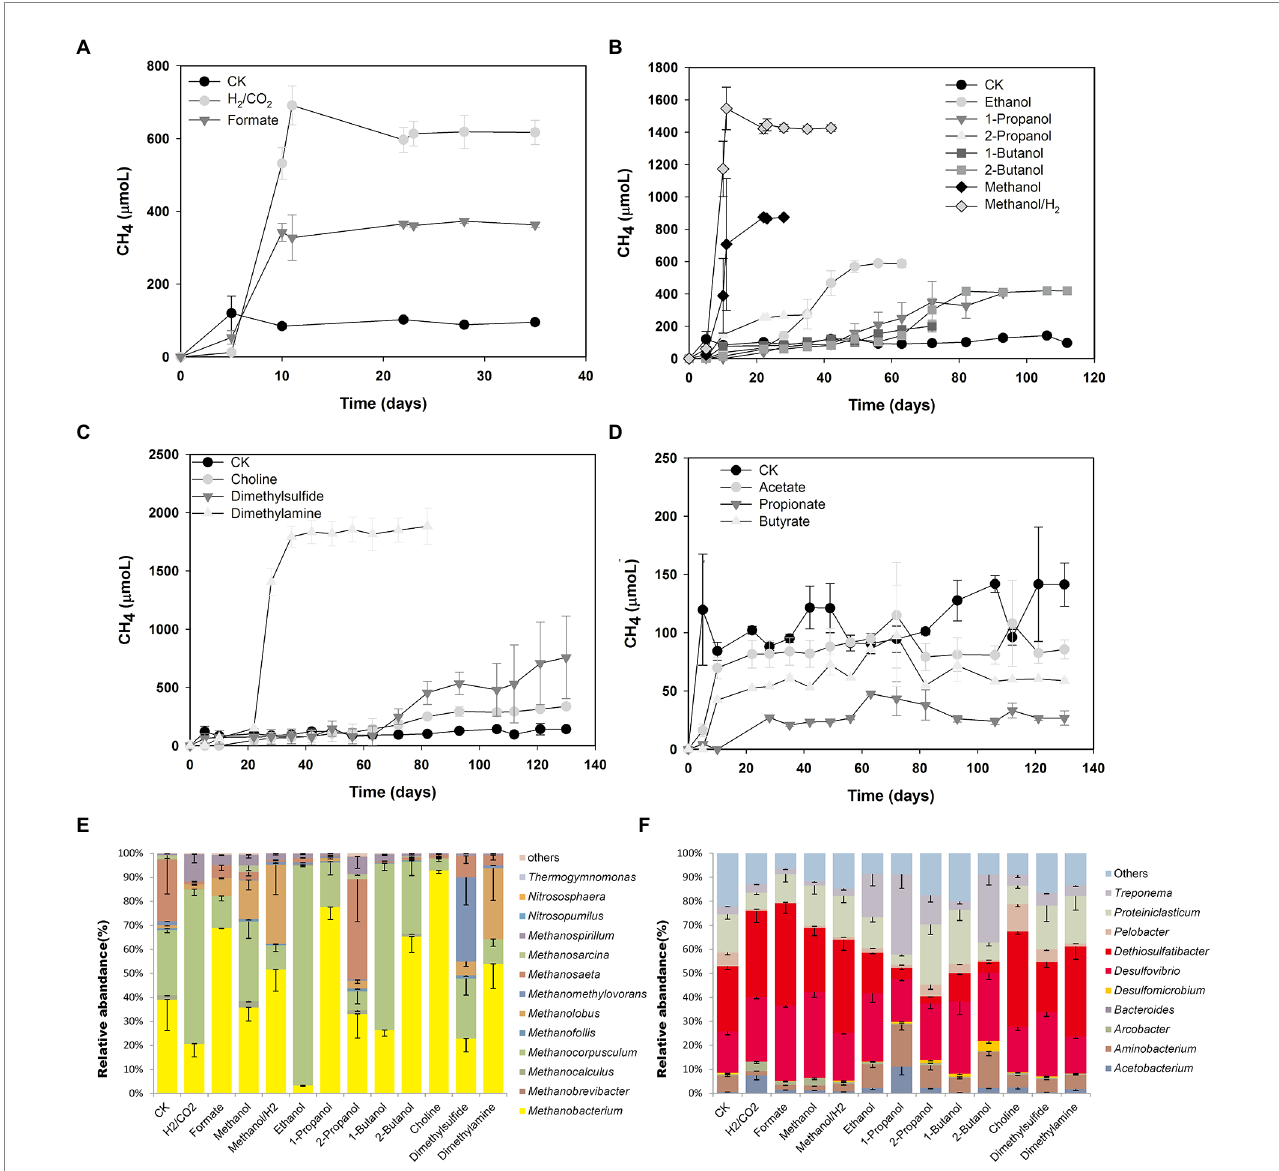
FIGURE 3 Methane production potential and microbial community structure of different methane precursors. Methane production from H 2 /CO 2 and formate (A) , short- chain fatty alcohols (B) , methyl compounds (C) , and short-chain fatty acids (D) . The relative abundances of archaeal (E) and bacterial (F) 16S rRNA